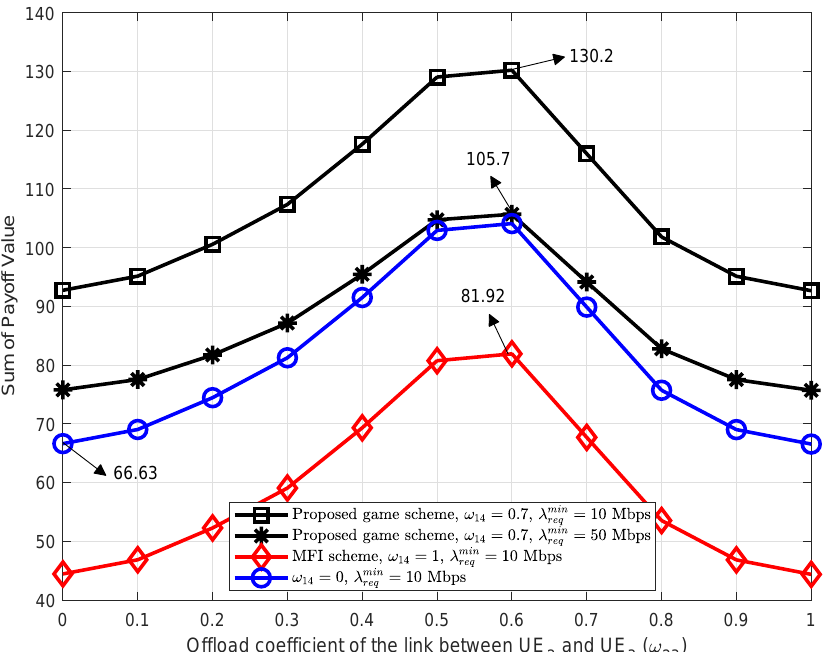
Figure 8. The sum of payoff according to offload coefficient pairs of the link between UE 2 –UE 3 ( ω 23 ) and the link UE 1 –UE 4 ( ω 14 ) when the minimum required data rate is 10 Mbps and 50 Mbps, respectively, and e hv mean = 15